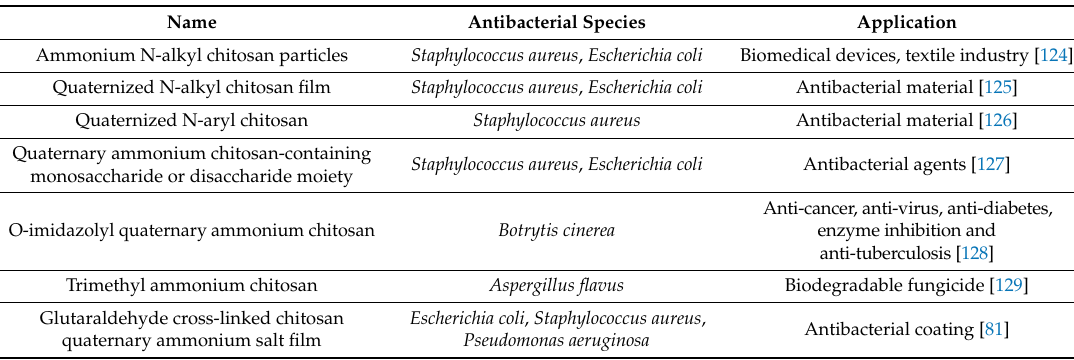
Table 1. Applications of quaternary ammonium chitosan in